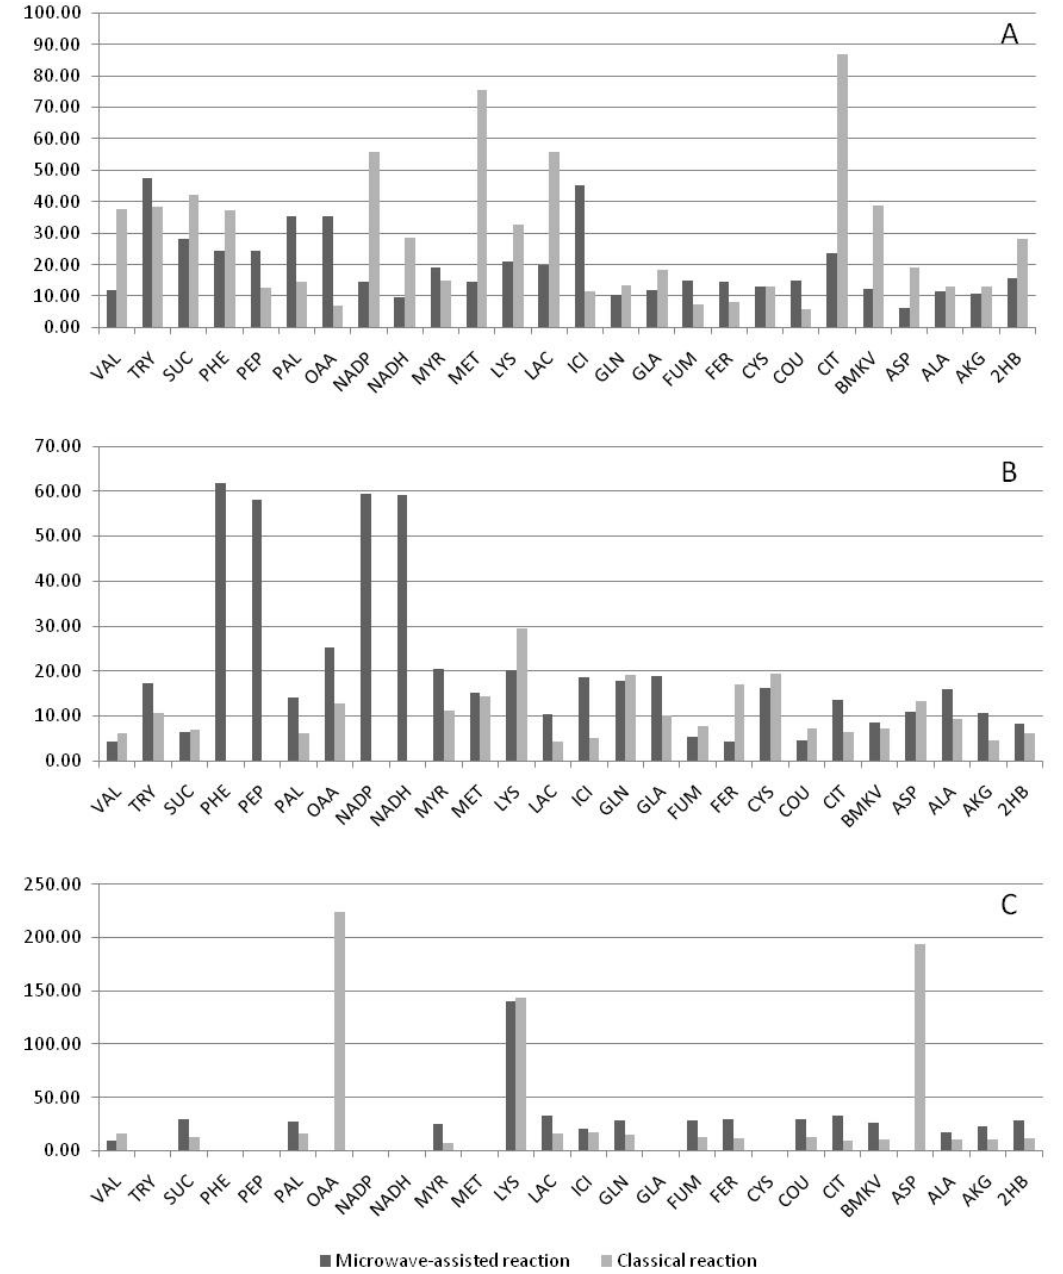
Figure 5. Reproducibility (RSD) of the TMS derivatization for several metabolites using two different reaction protocols: Microwave-assisted reaction according to Villas-Bôas et al. [6], and the classical reaction according to Roessner et al. [4]. ( A ) 100 p mols/sample; ( B ) 50 p mols/sample; ( C ) 25 p mols/sample. See Table 1 for metabolite